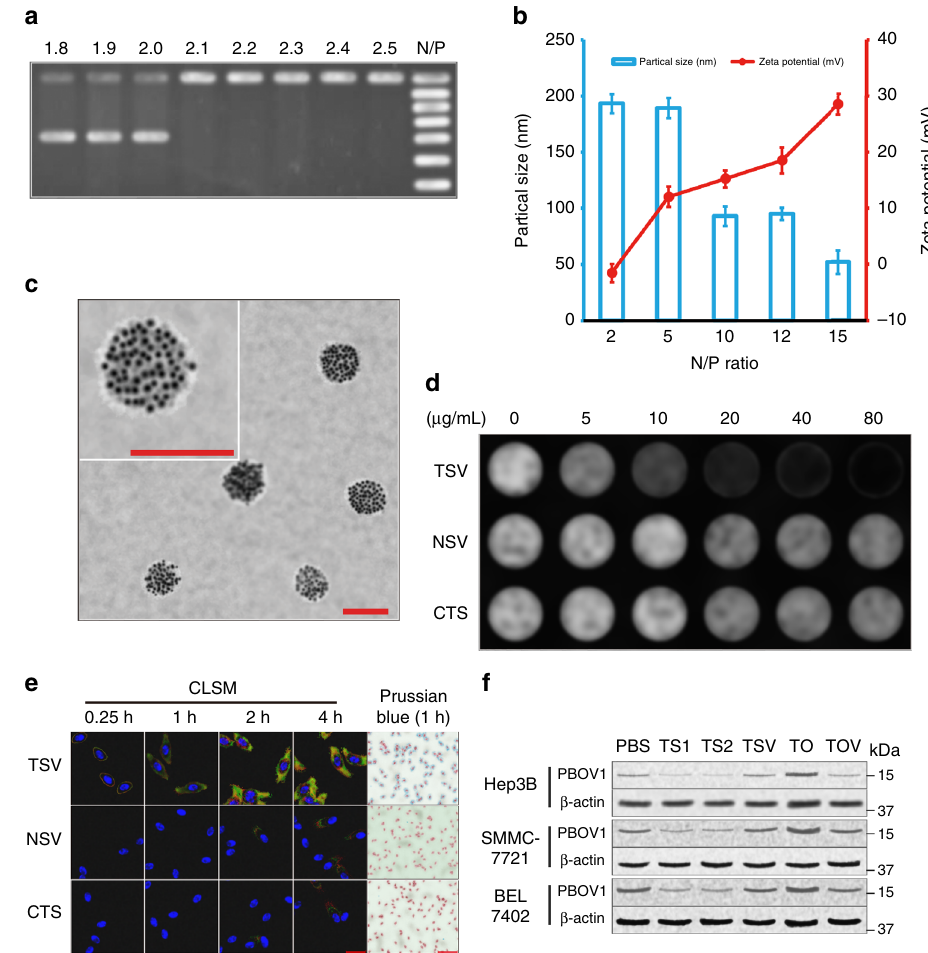
Fig. 2 Physicochemical properties and HCC cell transfection of scAb-EGFR-targeted nanomedicine. a Determination of plasmid DNA (pDNA) complexation at various nitrogen/phosphorus (N/P) ratios by gel retardation assay. Full complexation with single-chain antibody (scAb)-EGFR-PEG-g-PEI-SPION prevents DNA migration into the gel. b Particle size and zeta potential of scAb-EGFR-PEG-g-PEI-SPION/pDNA at various N/P ratios. Data were represented as means± S.D. Error bars represent the S.D. values ( n = 3). c Transmission electron microscopy (TEM) images of nanomedicine scAb-EGFR- PEG-g-PEI-SPION/pDNA. The gray halo around the dark SPION cluster indicates a polymeric shell. Scale bar, 100 nm. d T2-weighted magnetic resonance imaging (MRI) examination of different groups of Hep3B cells after 1 h of incubation at Fe concentrations of 0, 5, 10, 20, 40, and 80 μ g/mL. e Left four panels, confocal laser scanning microscopic (CLSM) imaging of different groups of Hep3B cells incubated for 0.25, 1, 2, 4 h, respectively, at Fe concentration of 20 μ g/mL. Scale bar, 10 μ m. (Blue, DAPI-indicating nuclei; red, POPO-3 indicating pDNA; green, Oregon Green 488-indicating delivery agent; Overlapping of red and green fl uorescence to generate a yellow one, see also Supplementary Fig. 1d). Right panel, Prussian blue staining images of different groups of Hep3B cells incubated at the same conditions as in CLSM studies. Scale bar, 50 μ m. (Blue, indicating Fe aggregation; red, indicating nuclei). f Protein expression levels of PBOV1 in Hep3B, SMMC-7721, and BEL7402 cells relative to β -actin as control determined by western blotting